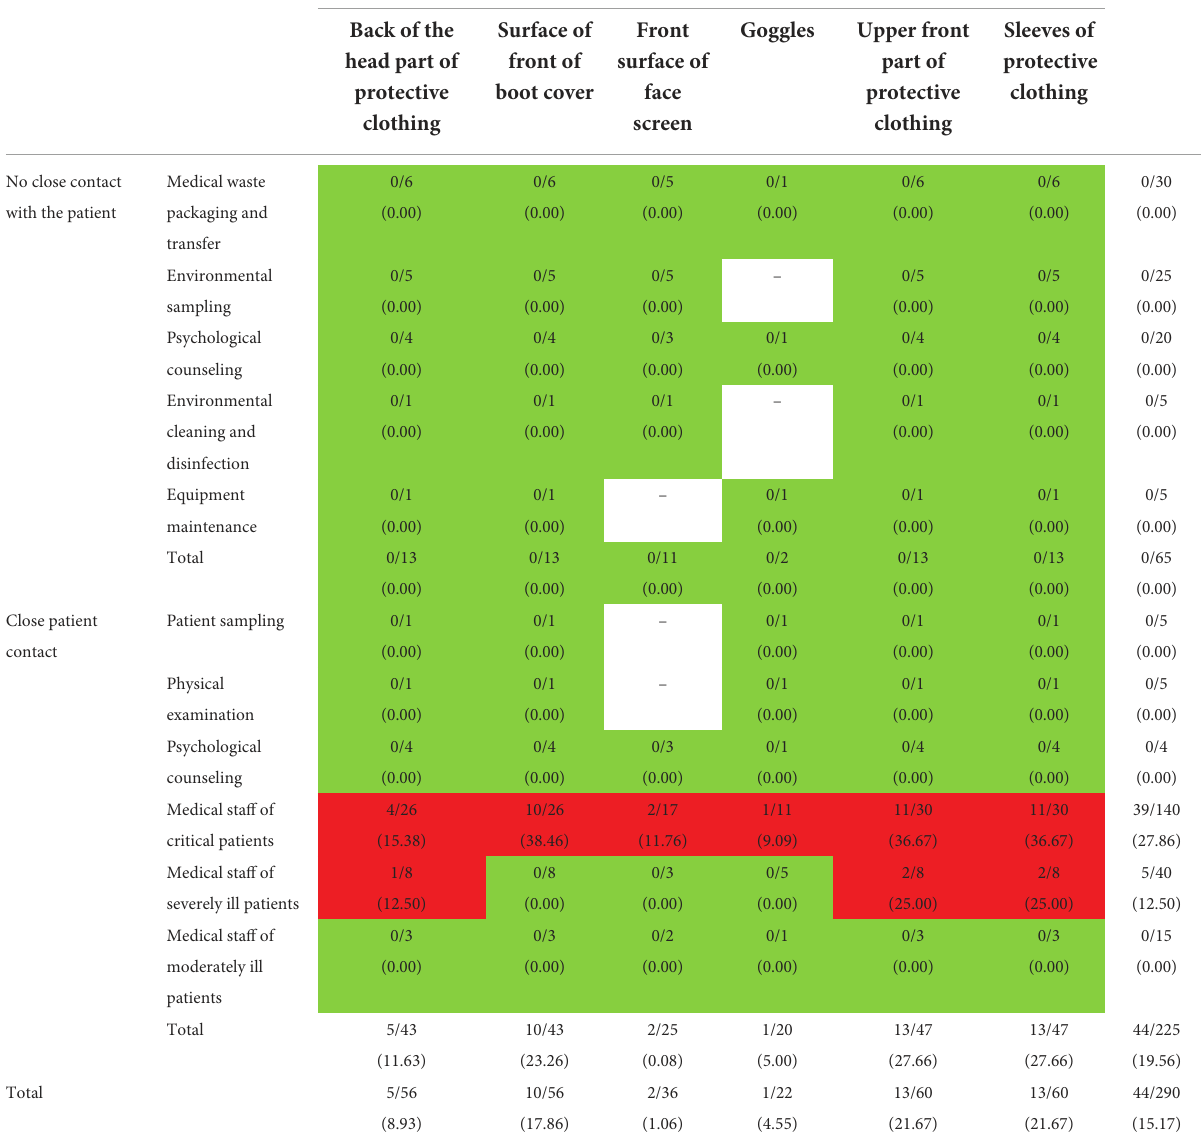
TABLE 4 Results of SARS-CoV-2 testing for PPE from medical staff exiting the contaminated areas before intervention. Medical staff No. of positive samples/no. of total samples (positivity rate, %) Total